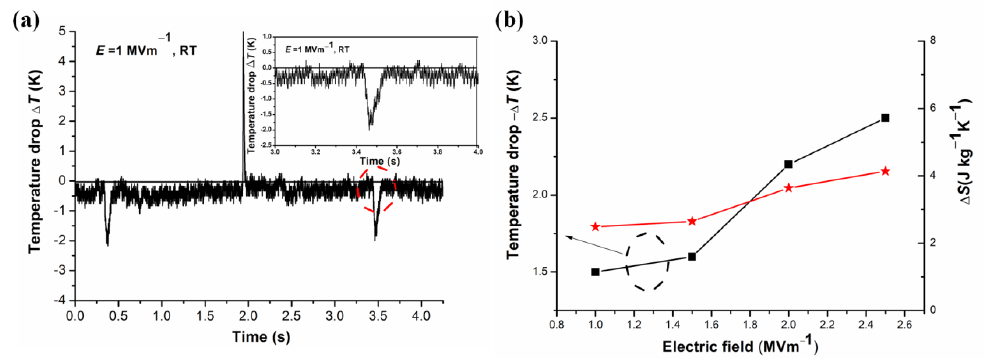
Figure 7. ( a ) Directly recorded ECE signal for the KN-BT(9/1) sample as the electric field was switched on and off. Solid line is drawn to show the ambient temperature. The amplified temperature drop is shown as the inset. ( b ) ECE‒induced adiabatic temperature drop ( ∆𝑇 ) and isothermal entropy change ( ∆𝑆 ) as a function of electric field ( E ) at RT. The dash line is drawn to guide eyes. Note that the bimodal structured KN-BT(9/1) bulk ceramic sintered at 1050 °C using IAGG method was selected for the analysis. Error: within the noise range, it is about ± 0.2 °C.